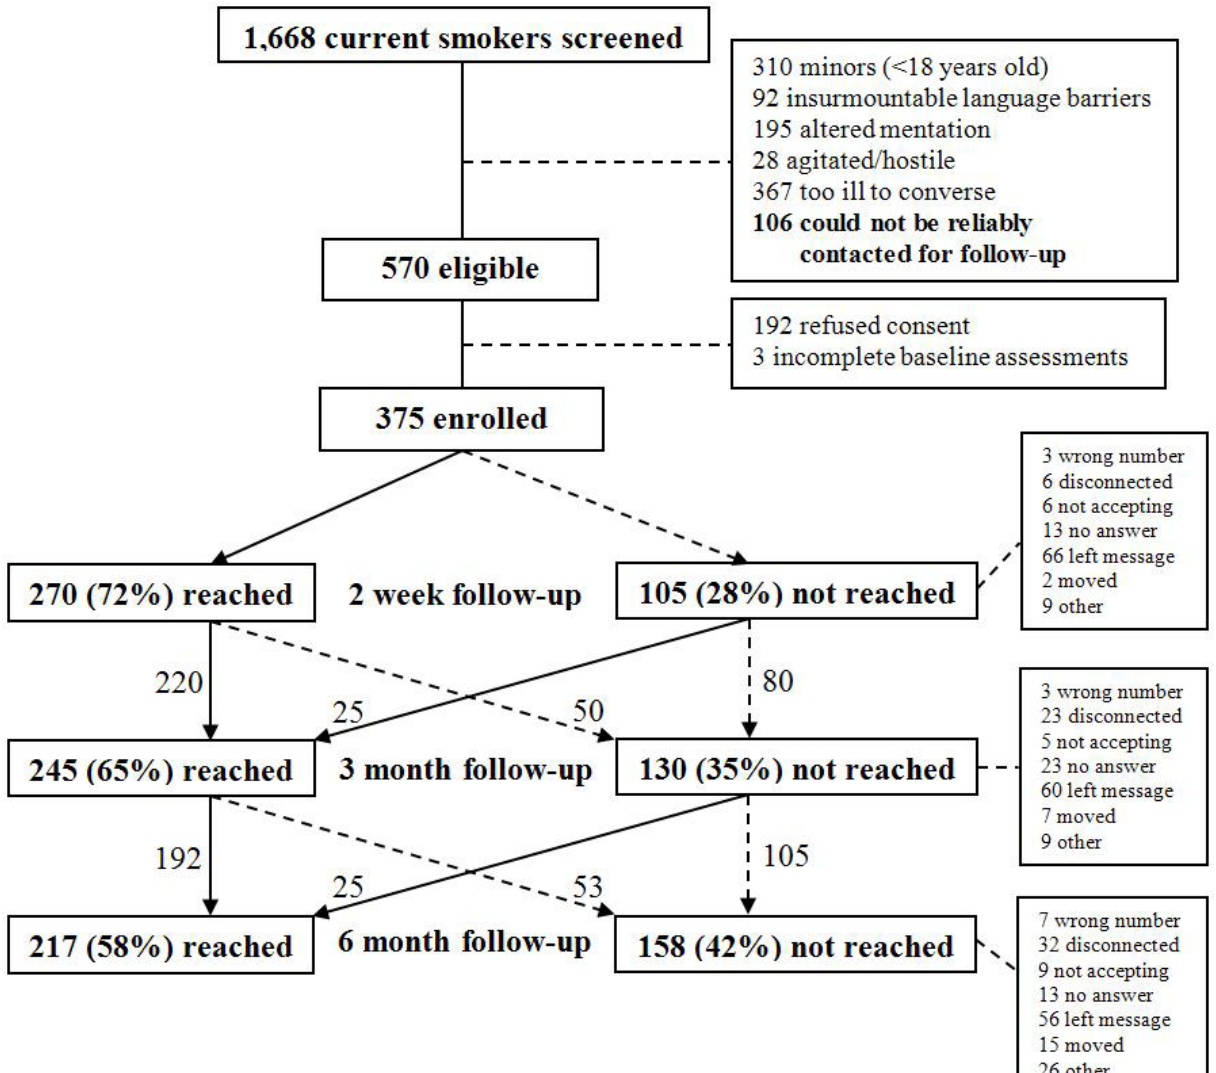
Figure 1. Eligibility and successful contact at 2 week, 3 month, and 6 month follow-up time